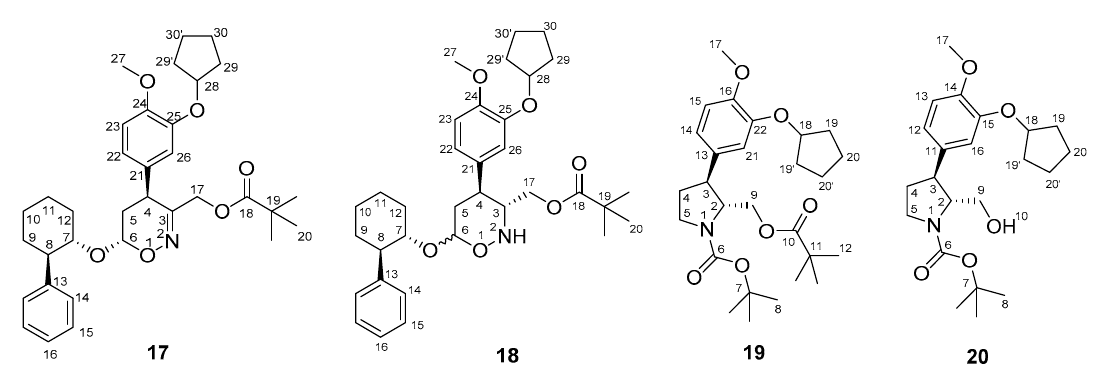
Figure 1. Numeration of atoms in products 17 – 20.